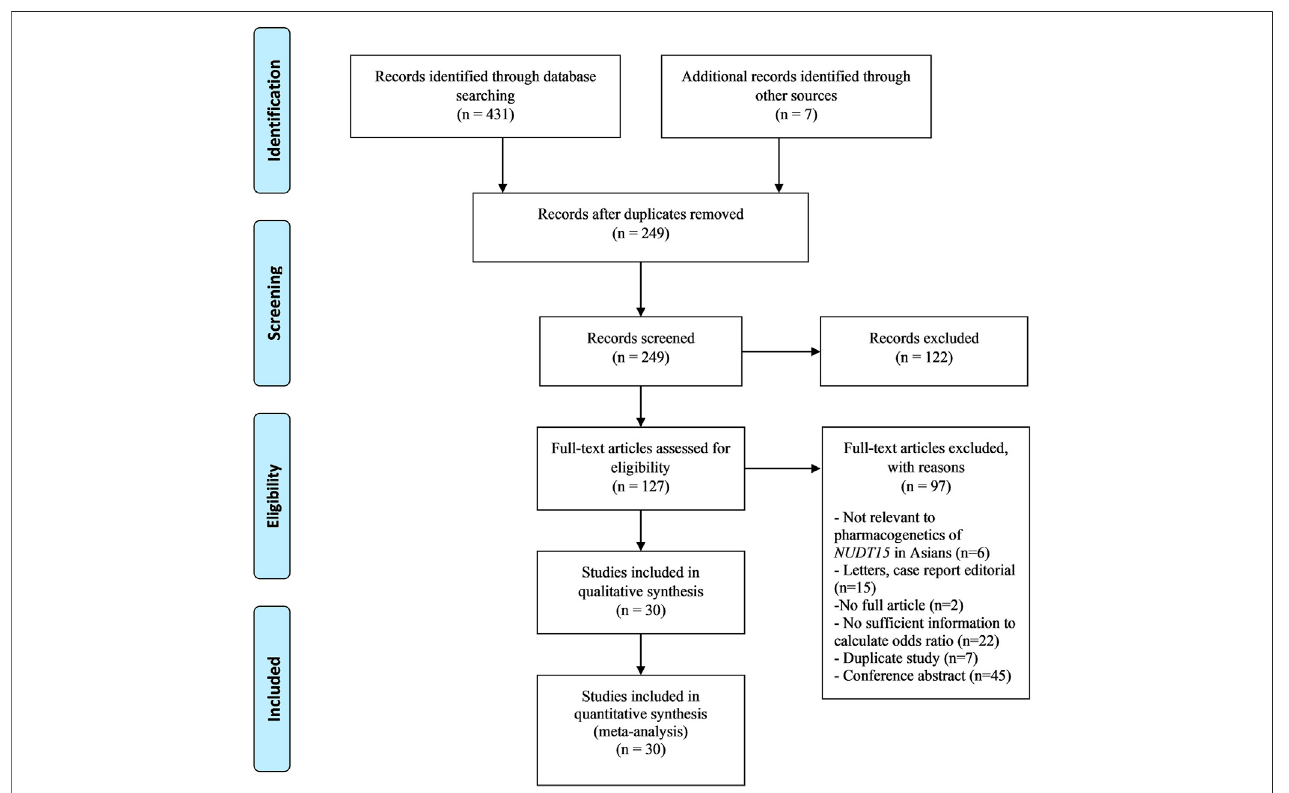
FIGURE 1 | Study selection